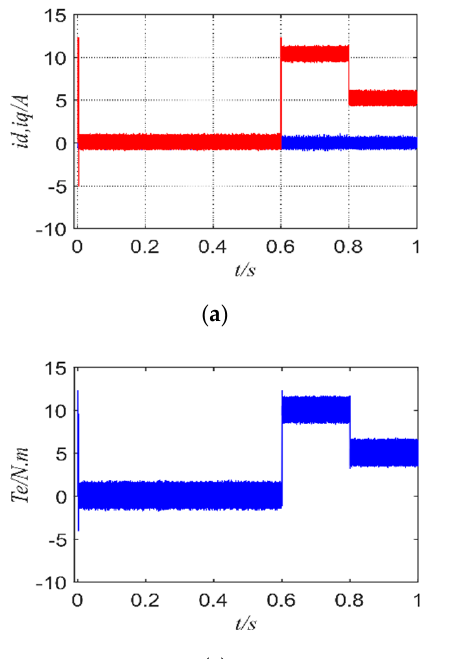
( d ) Figure 16. FCS-MFPCC simulation results under parameter perturbation when the sampling period is 10 us: ( a ) dq -axis current of FCS-MFPCC; ( b ) speed of FCS-MFPCC; ( c ) torque of FCS-MFPCC; ( d ) observed values of the unknown quantities Fd and Fq under parameter perturbation. Comparing Figure 15 with Figure 16, it can be seen that in the event of motor param- eter perturbation, the dq -axis current of the FCS-MPCC algorithm fluctuates greatly, and the load torque also fluctuates greatly, causing unstable speed, and the actual speed devi-